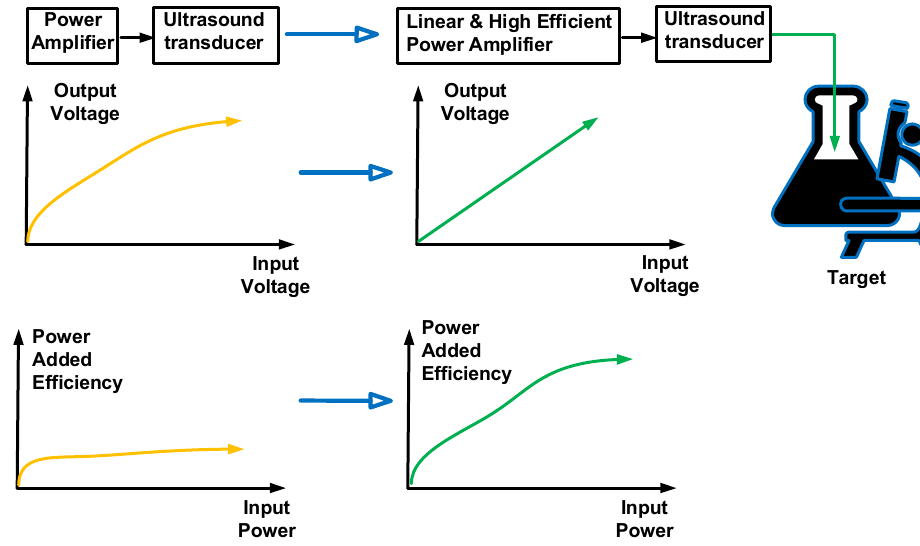
Figure 1. Concept of a Class-E power amplifier for ultrasound transducer.